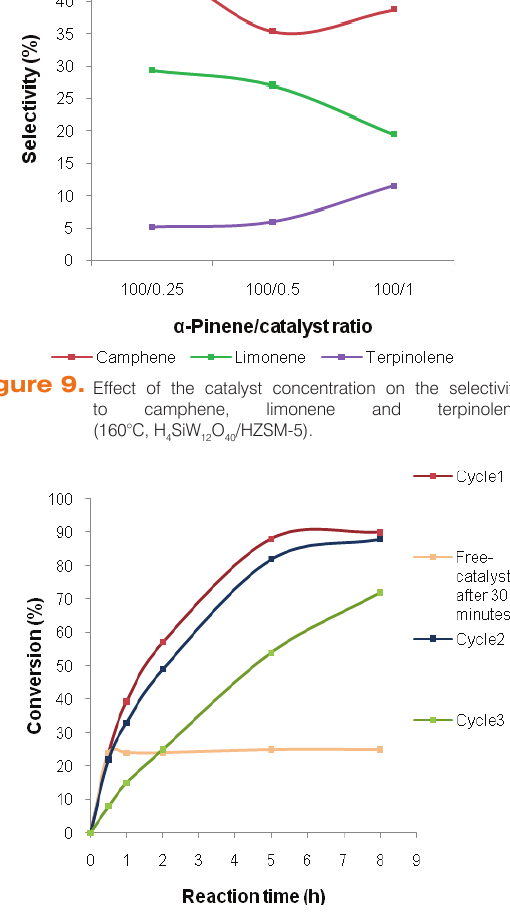
and the effect of the SiW leaching for H catalyst ( α -pinene/catalyst ratio of 100/1, at